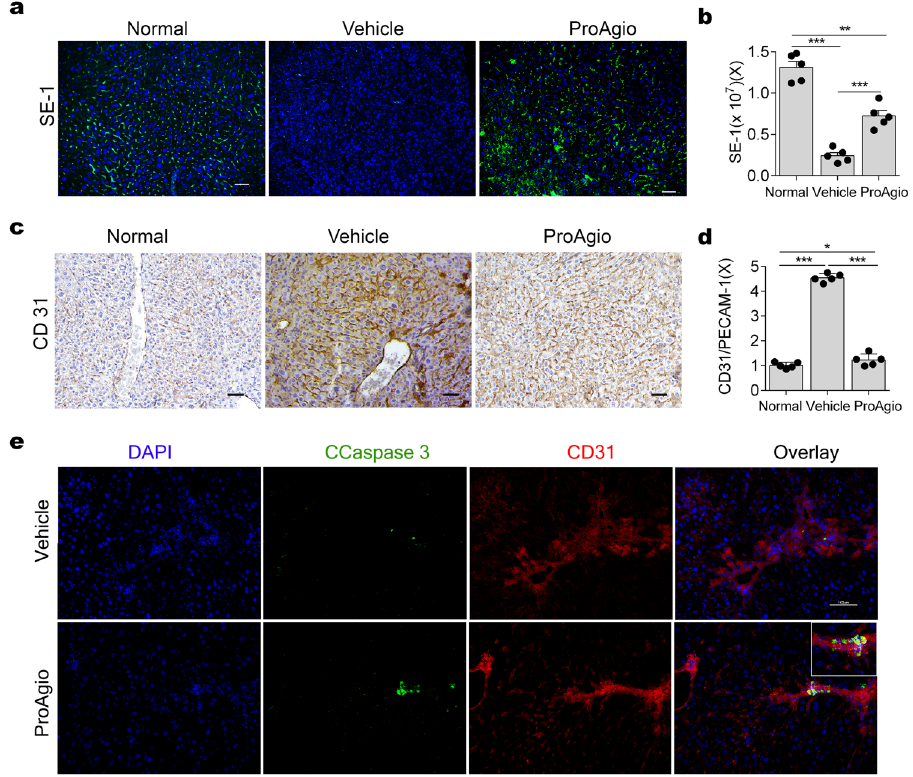
antibody recognizing a differentiated LSEC marker, and b quantitation of SE-1 IF staining of liver tissue sections from mice treated with indicated agents. The quantity of SE-1 IF is presented as a fold change in SE-1 stain compared with that of non- fi brotic mice (normal). c Representative images of IHC stain of CD31 and d quantitation of CD31 IHC stain of liver tissue sections from mice treated with indicated agents. The quantity of CD31 IHC is presented as a fold change in CD31 stain compared with that of non- fi brotic mice (normal). e Representative images of IF staining of CD31 (Red) and cleaved caspase-3 (green) and the overlay of co-stains (Yellow) of liver sections from mice treated with indicated agents. Scale bars in a , c , and e show 100 µ m. Error bars in b and d are standard deviations of measurements of 10 mice. Normal in a – d are the mice without fi brosis induction and treatment. * P < 0.05; ** P < 0.01, *** P <